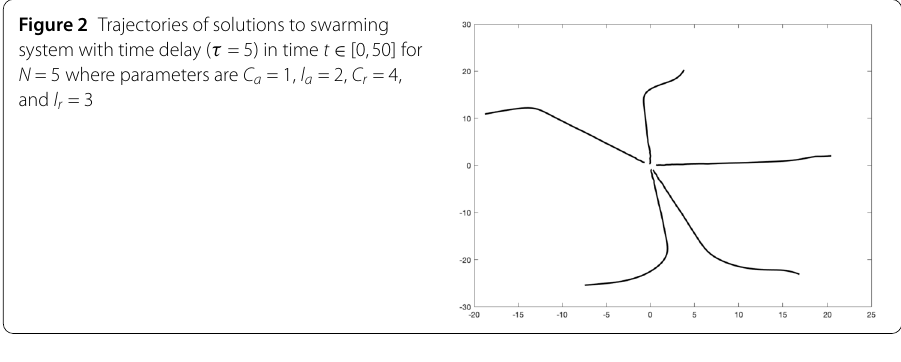
Figure 3 Simulation of the swarming system with time delay ( τ = 5) for N = 5 in time t ∈ [0,50] where parameters are given as C a = 1, l a = 2, C r = 4, and l r =